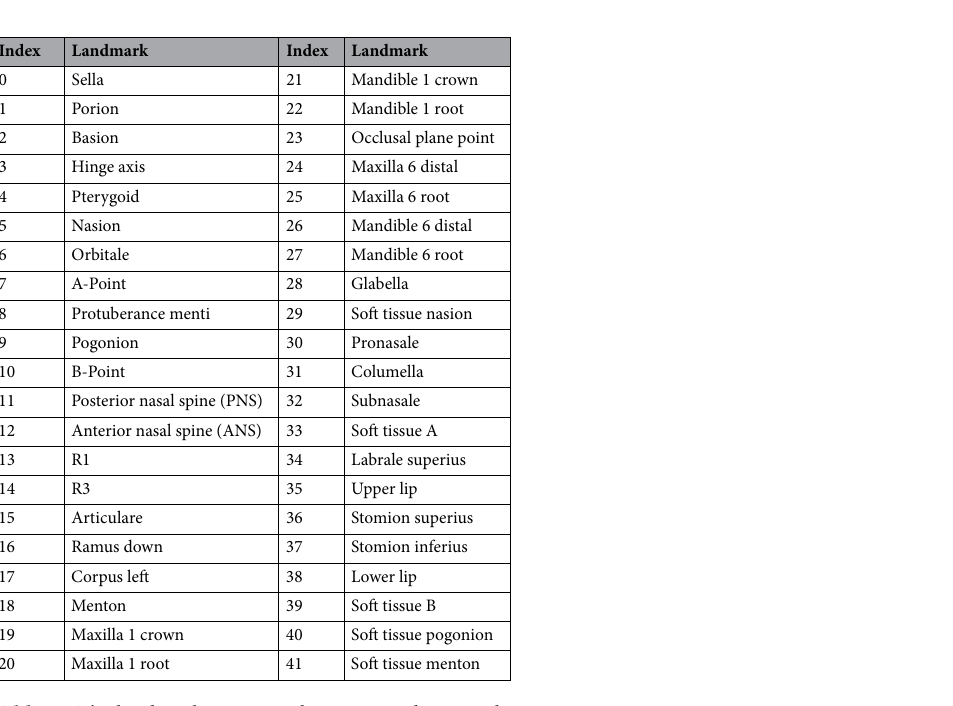
Table 1. The landmark names with corresponding numbers in Fig.